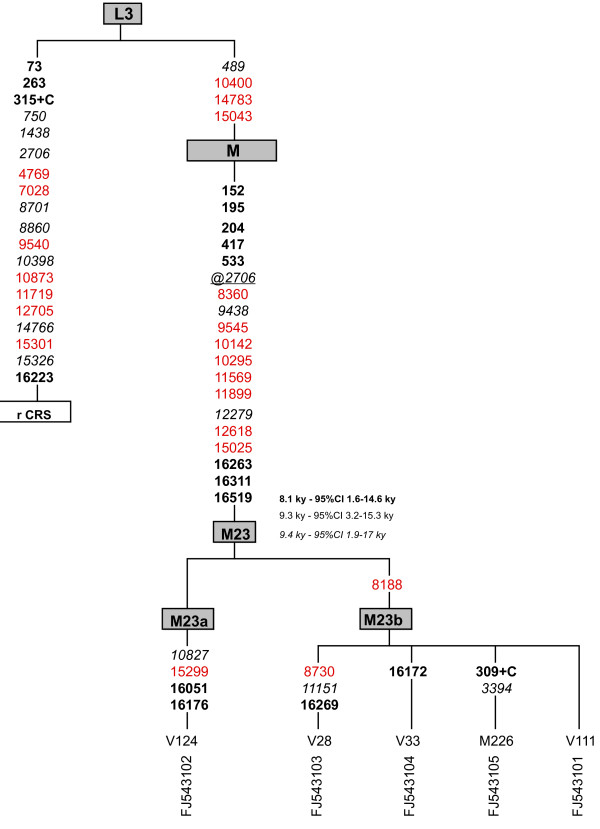
Phylogenetic tree constructed from complete mtDNA sequences for five Malagasy individuals. M and V represents the Mikea and Vezo populations, respectively. Mutations were scored relative to the rCRS [42]. Numbers along links refer to nucleotide positions. A plus sign (+) indicates an insertion. Recurrent mutations in the phylogeny are underlined. The prefix "@" indicates back mutations. Control region mutations are in bold, synonymous transitions are shown in red, and non-synonymous mutations are listed in italic. TMRCA estimates were calculated as in [35,36,56], presented in italic, bold and regular font, respectively, and are presented in units of thousands of years before present.